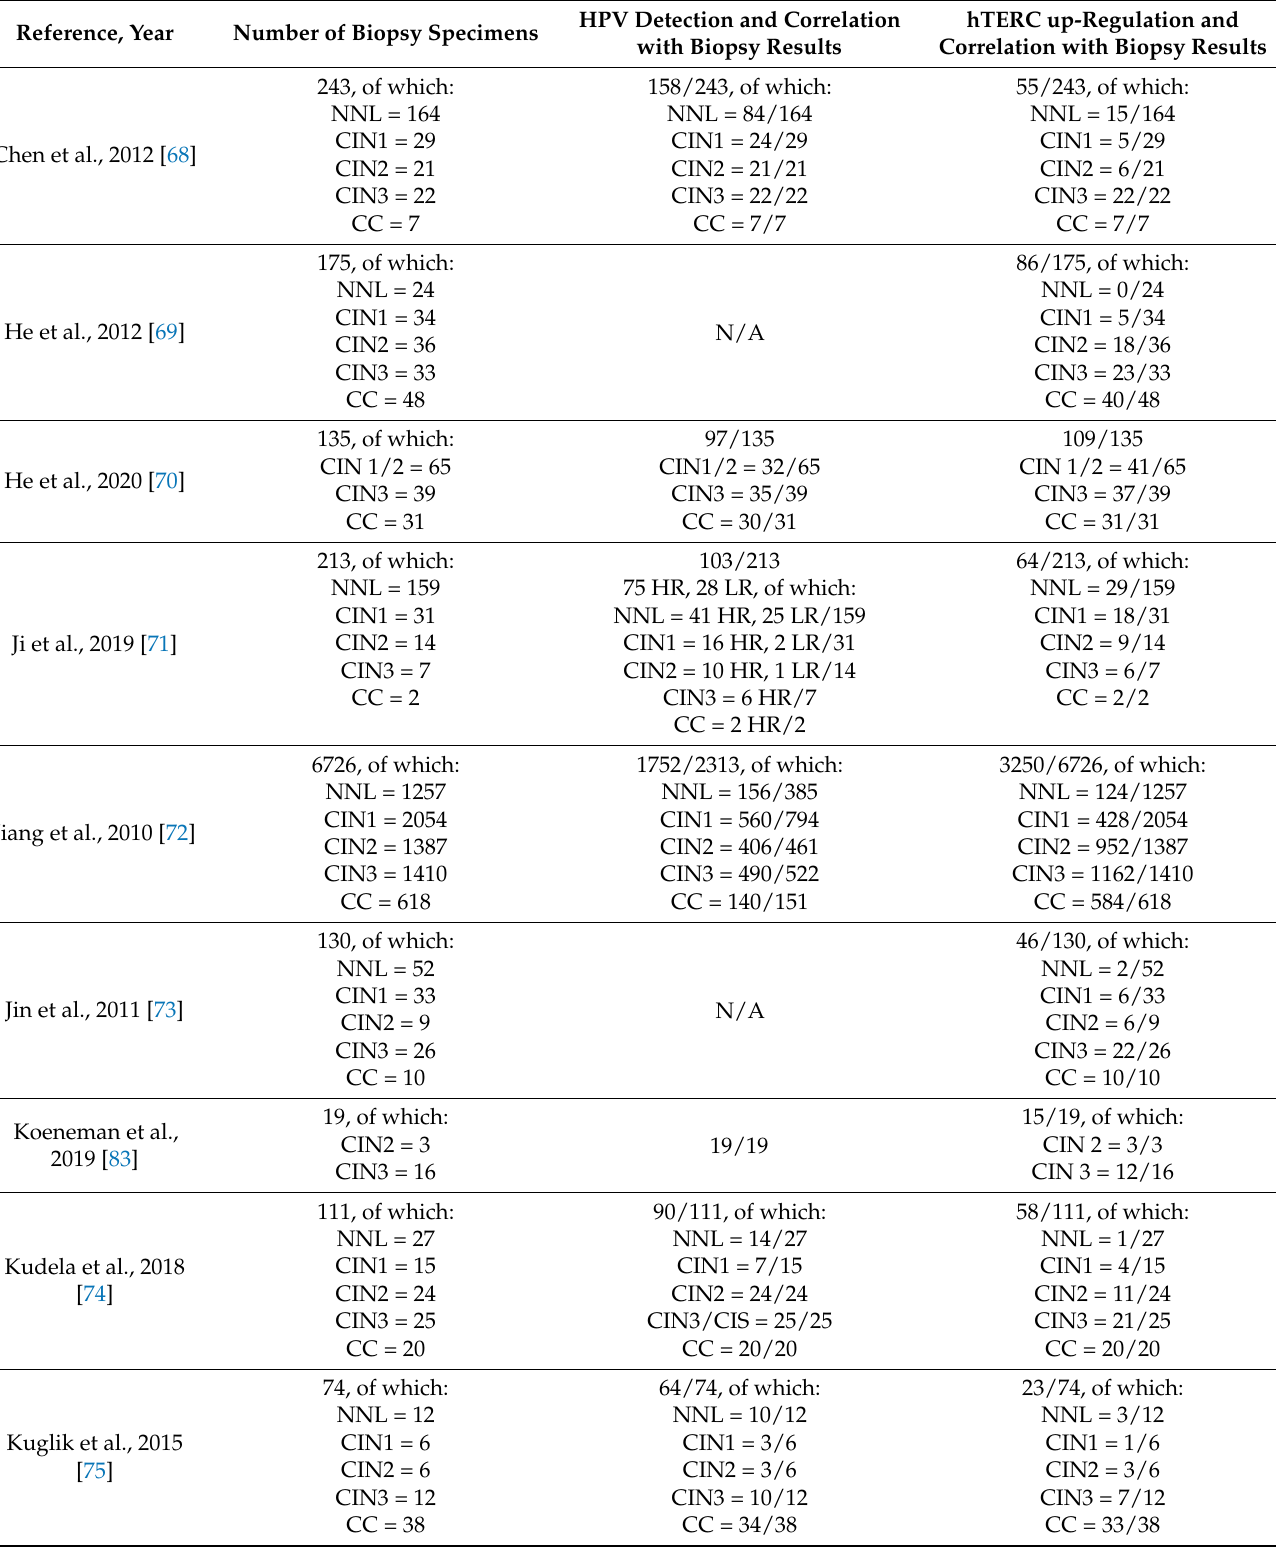
Table 4. hTERC up-regulation in cervical tissue biopsy